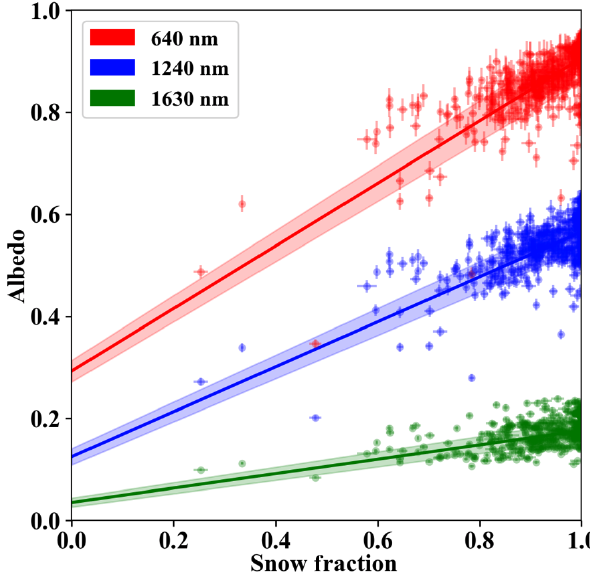
Figure 4. Estimated snow fraction from nadir imagery versus SSFR–BBR-measured surface albedo at 640, 1240, and 1630nm. The surface albedo and snow fraction uncertainties are indicated as vertical and horizontal error bars. The solid lines show linear re- gression fits, and the shaded region indicates their